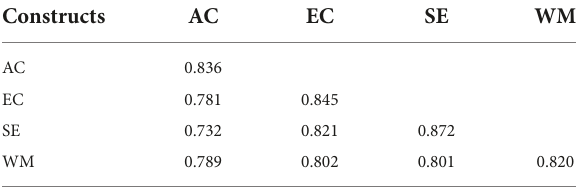
TABLE 3 Discriminant validity (Fornell-Larcker